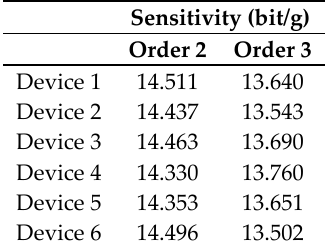
Figure 5. Power spectrum density. Table 2. Experimental